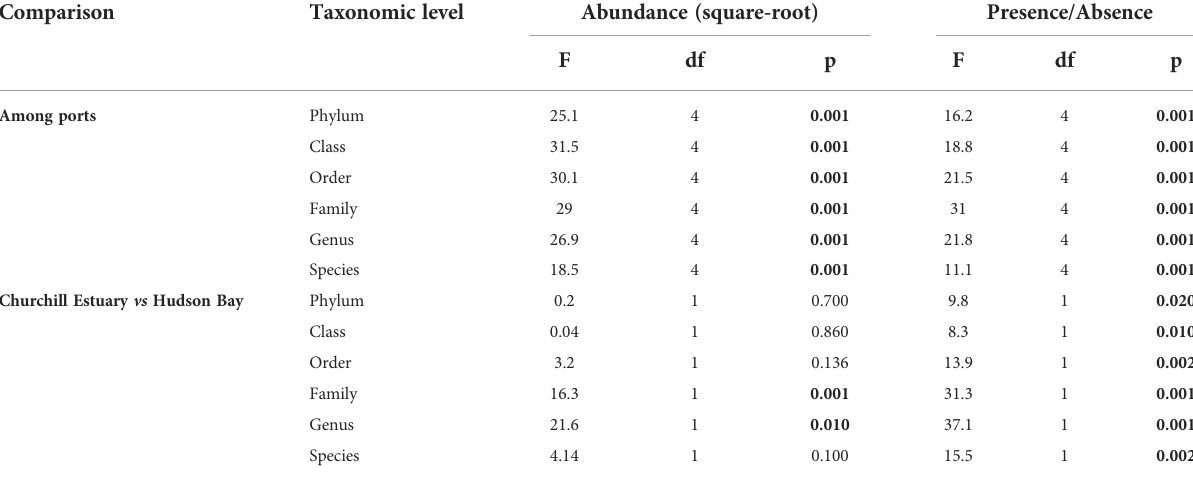
TABLE 4 Results of PERMISP on similarity matrices derived from square-root transformed abundance and presence/absence data.